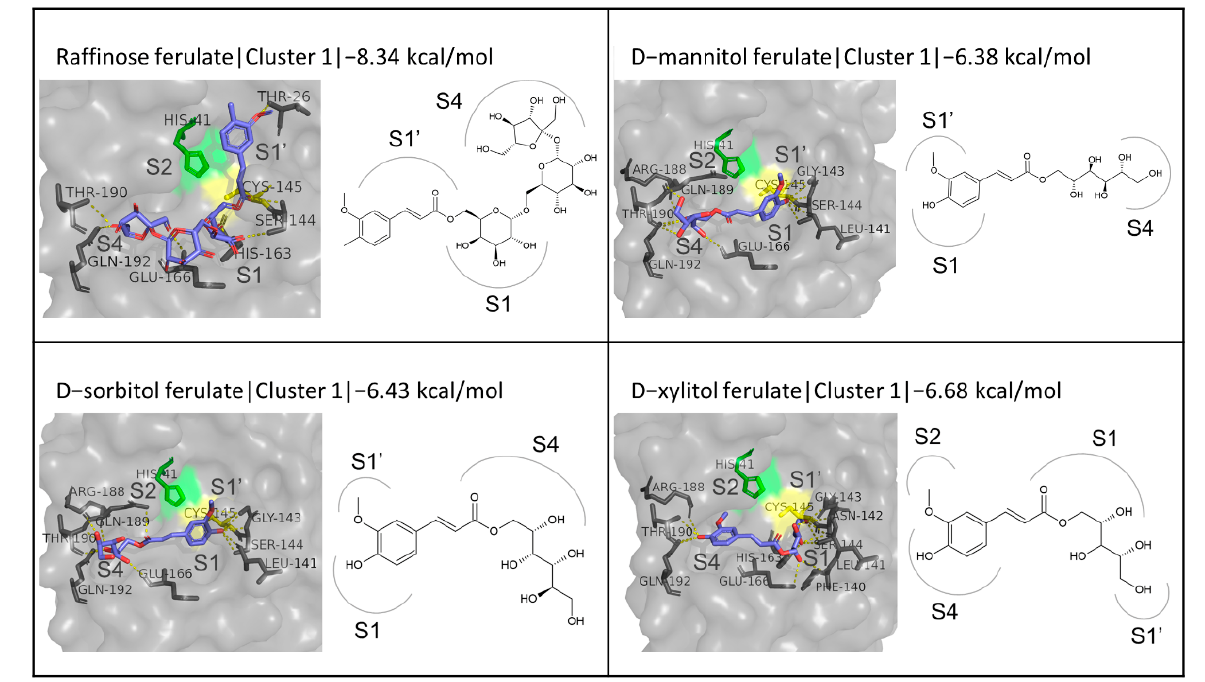
Figure 8. Structures and binding modes of trisaccharide and polyol esters of FA at the active site of M pro .